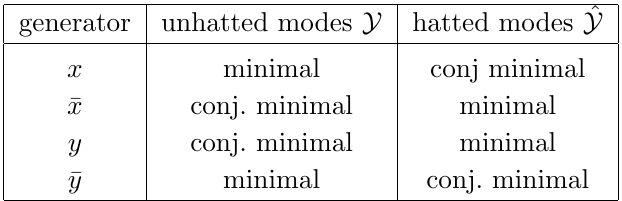
Table 1 . The representation properties of the fermionic